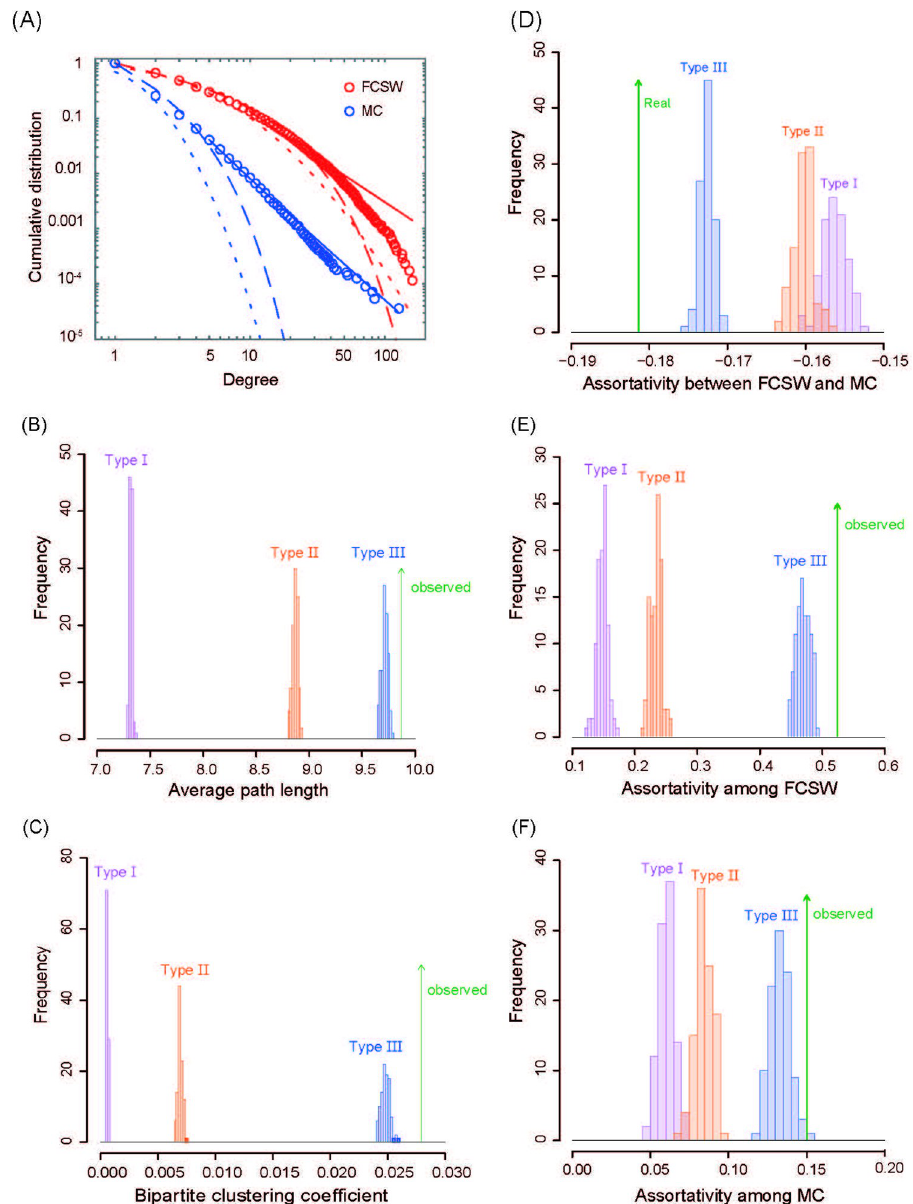
Fig 3. Results of network analysis. (A) Cumulative distribution of degree. Circles represent real data. Red and blue correspond to FCSW and MC, respectively. The solid lines, dashed curves, and dotted curves correspond to power-law distribution, negative binomial distribution, and log-normal distribution, respectively. The best fit can be evaluated by BIC or AIC, as shown in S1 Table. (B) Aaverage path lengths. (C) Bipartite clustering coefficients. (D), (E), (F) correspond to the assortativity coefficient between FCSWs and MCs, that for FCSW–FCSW projection networks, and that for MC–MC projection networks, respectively. The green upward arrows represent the assortativity coefficients of the observed network. For comparison, we show the result for three types of artificially generated networks, where 100 networks are prepared and their distributions are shown. To evaluate the robustness and fragility of the network, we investigated the changes in the three network indices when nodes were deleted from a high degree. Fig 4A shows the change in the size of the GCC; the red and blue curves depict cases when FCSWs and MCs are removed from a high degree, respectively. The horizontal axis is the proportion of removed